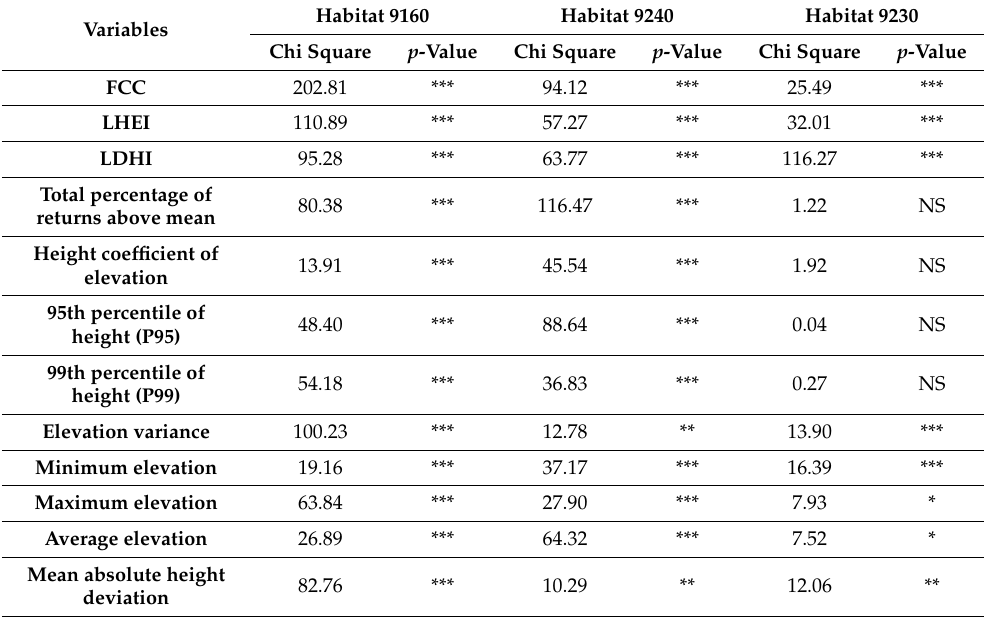
Table 3. Results of the Kruskal–Wallis test for habitats 9160, 9240, and 9230. *: p -value < 0.05; **: p -value < 0.01; ***: p -value < 0.001; NS: non-significant. Additionally, 9160 is Quercus robur habitat,